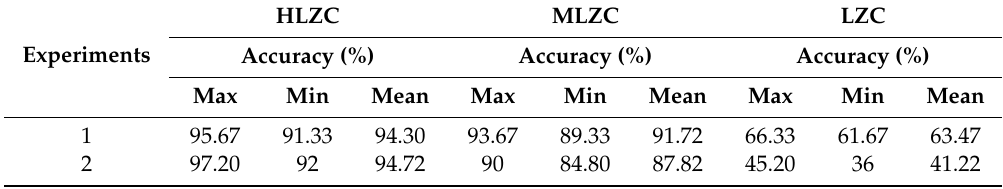
Table 3. Detailed information of five conditions in Experiment 2.